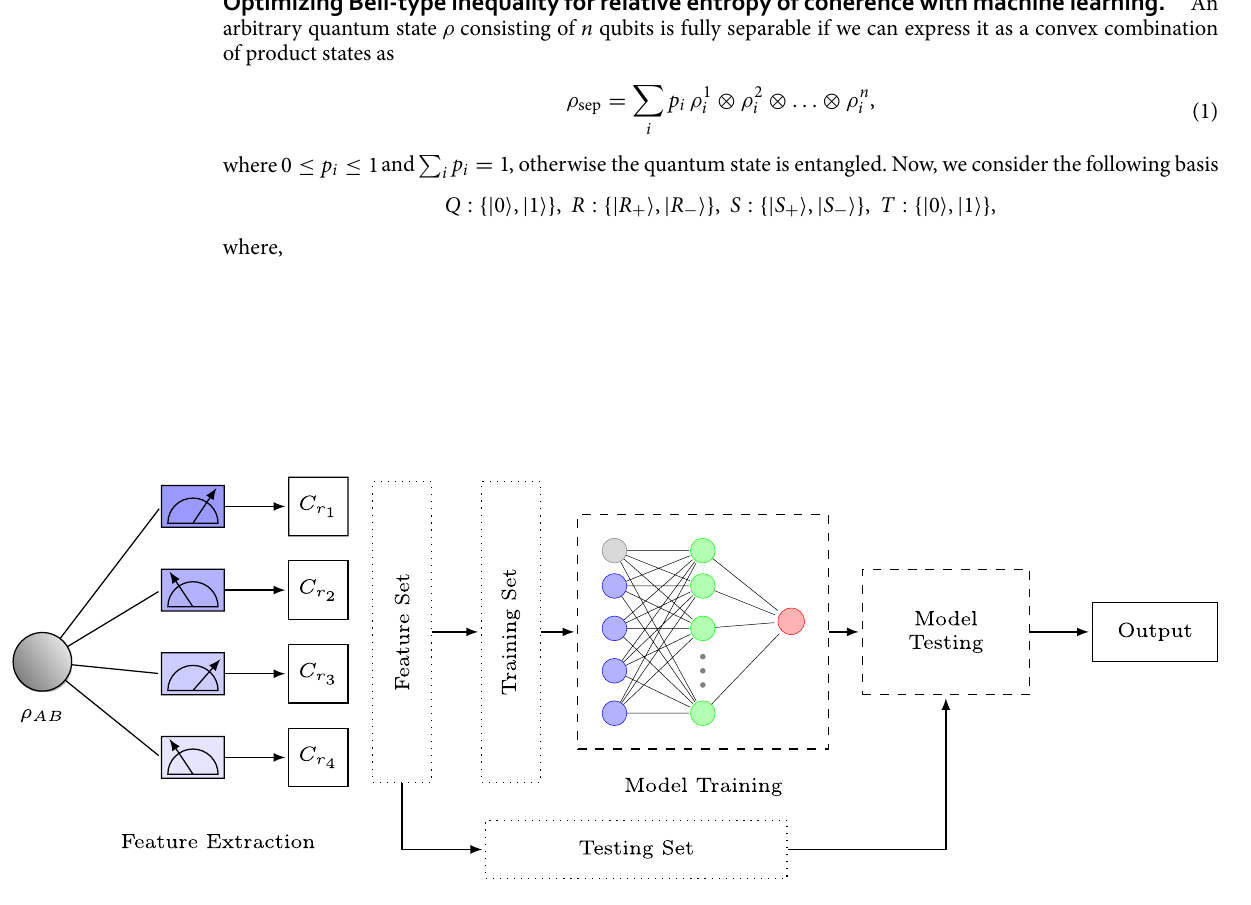
Figure 1. Coherence-based entanglement detection with artificial neural